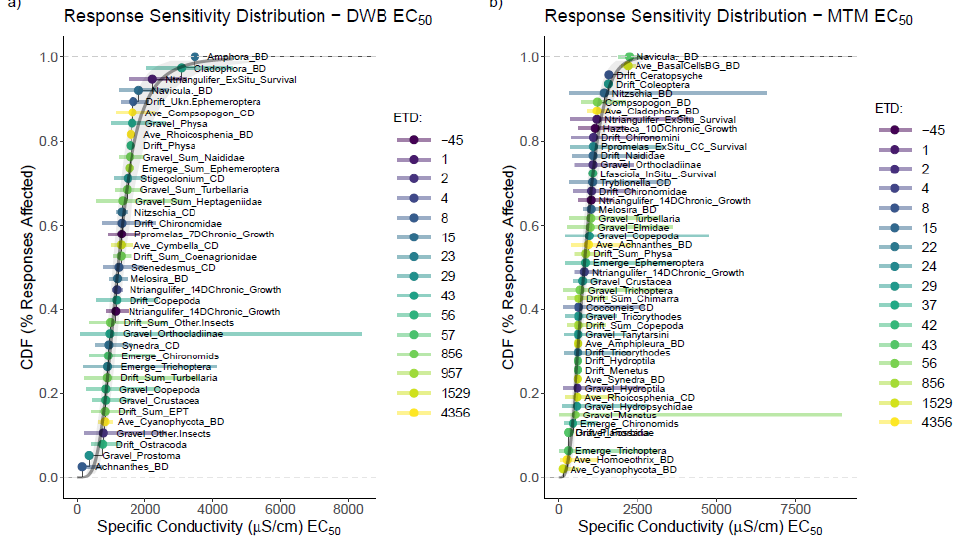
Figure 4. Taxa-level response sensitivity distributions for DWB ( a ) and MTM ( b ) recipes. Data are EC 50 SpCond. ETD is elapsed day during dosing period. Individual responses are color-coded by ETD. Horizontal lines are 95% CLs for EC 50 from LL2.4 DRM fit. ETD = 856 denotes a cumulative measure, summed over all events between days 8 and 56. ETD = 1529 and 4356 denote measures averaged among 15 and 29 or 43 and 56 sampling dates, respectively (periphyton measures only).